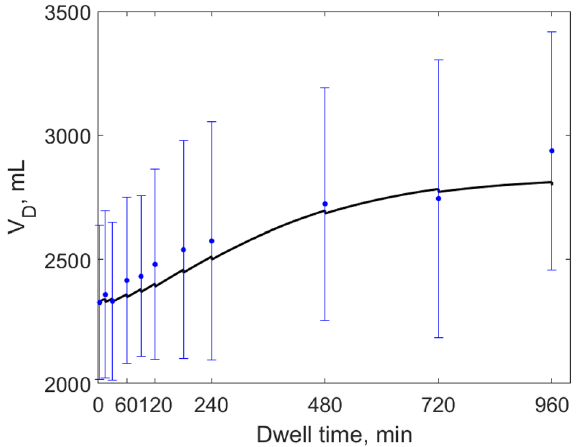
Figure 4. Measured values of intraperitoneal volume, V D (mean values from all patients ± SD, blue dots), and mean simulated profile for the extended model (black solid lines) during 16-h peritoneal dialysis with 7.5%